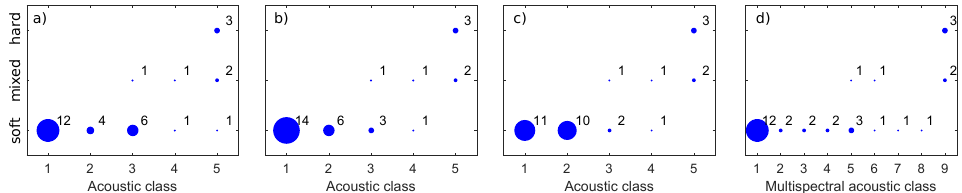
Figure 15. Video footage categories (soft, mixed, and hard) with ACs and MACs obtained from the single and multispectral Bayesian method at Bedford Basin 2016: ( a ) 100, ( b ) 200, and ( c ) 400 kHz and ( d ) combined. The numbers indicate how often the categorized video footage locations (see Figure 1a) are represented by a specific AC or